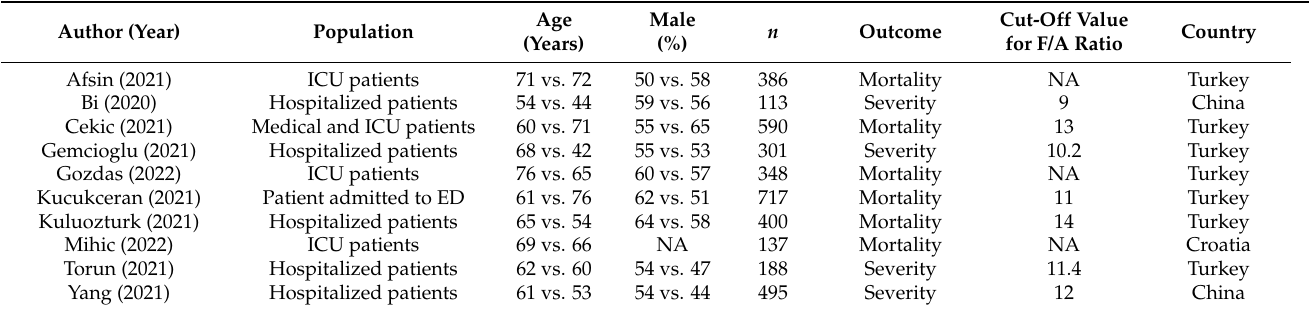
Table 1. Characteristics of studies ( n =